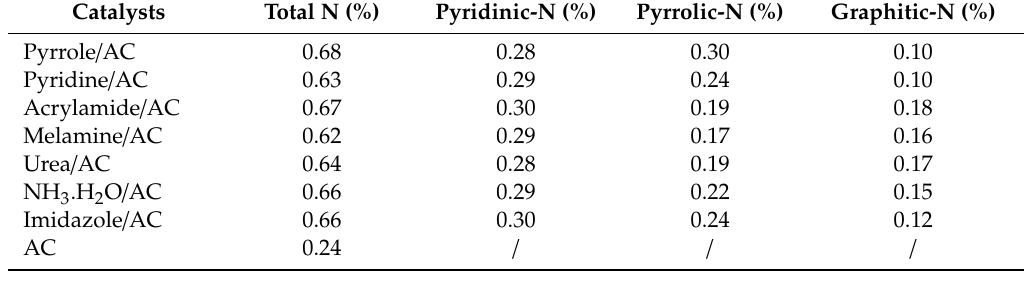
Table 1. The nitrogen composition in the catalysts by X-ray photoelectron spectroscopy (XPS). Catalysts